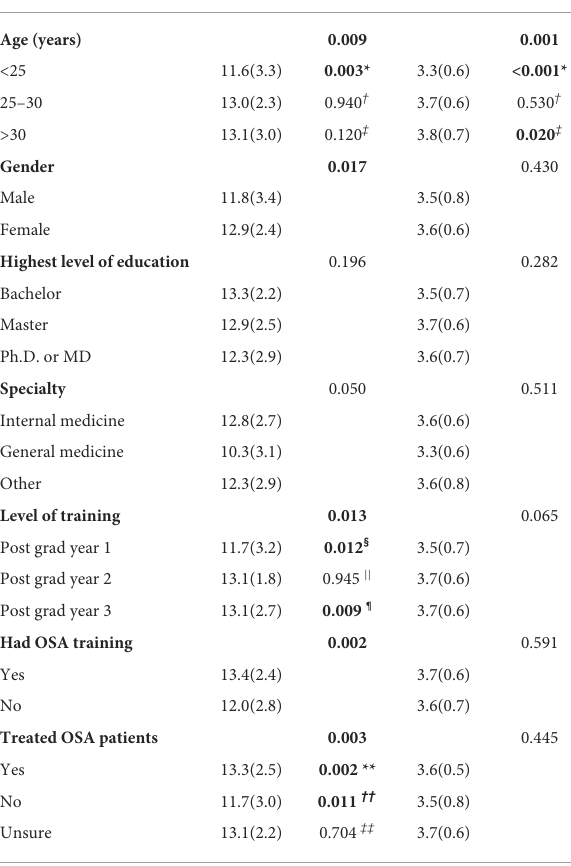
TABLE 3 Association between demographic characteristics and means of OSA knowledge and attitude score. Variables